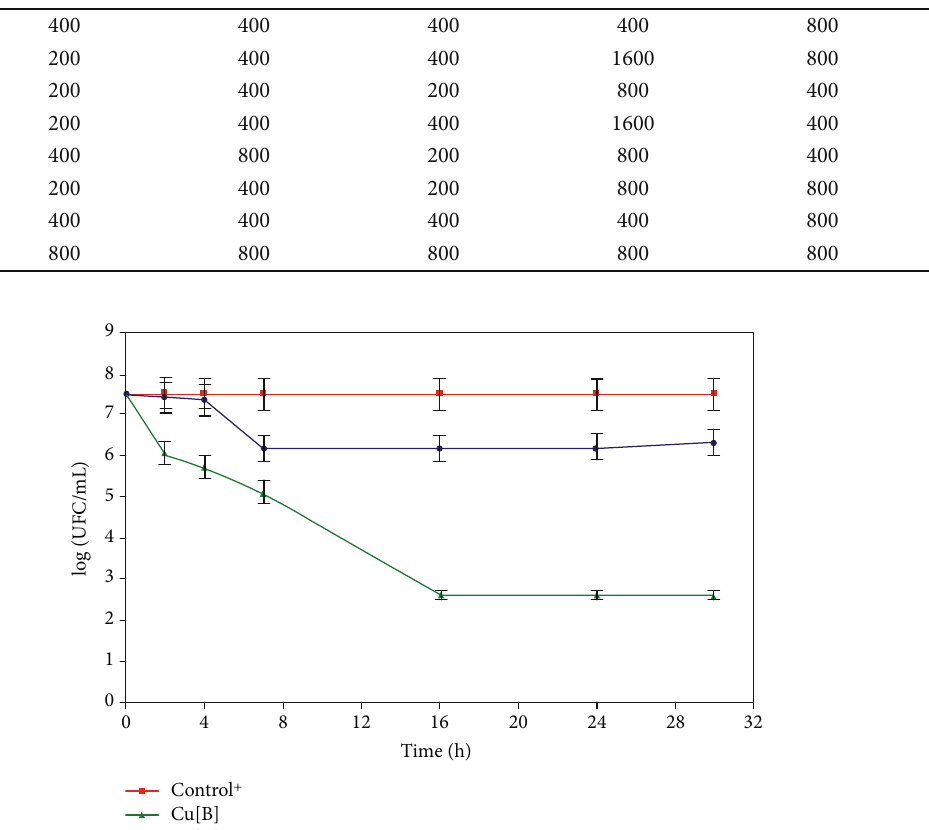
Table 6: Comparison of the MIC and MBC of samples against E. coli , S. aureus , and S. Typhi. Treatments